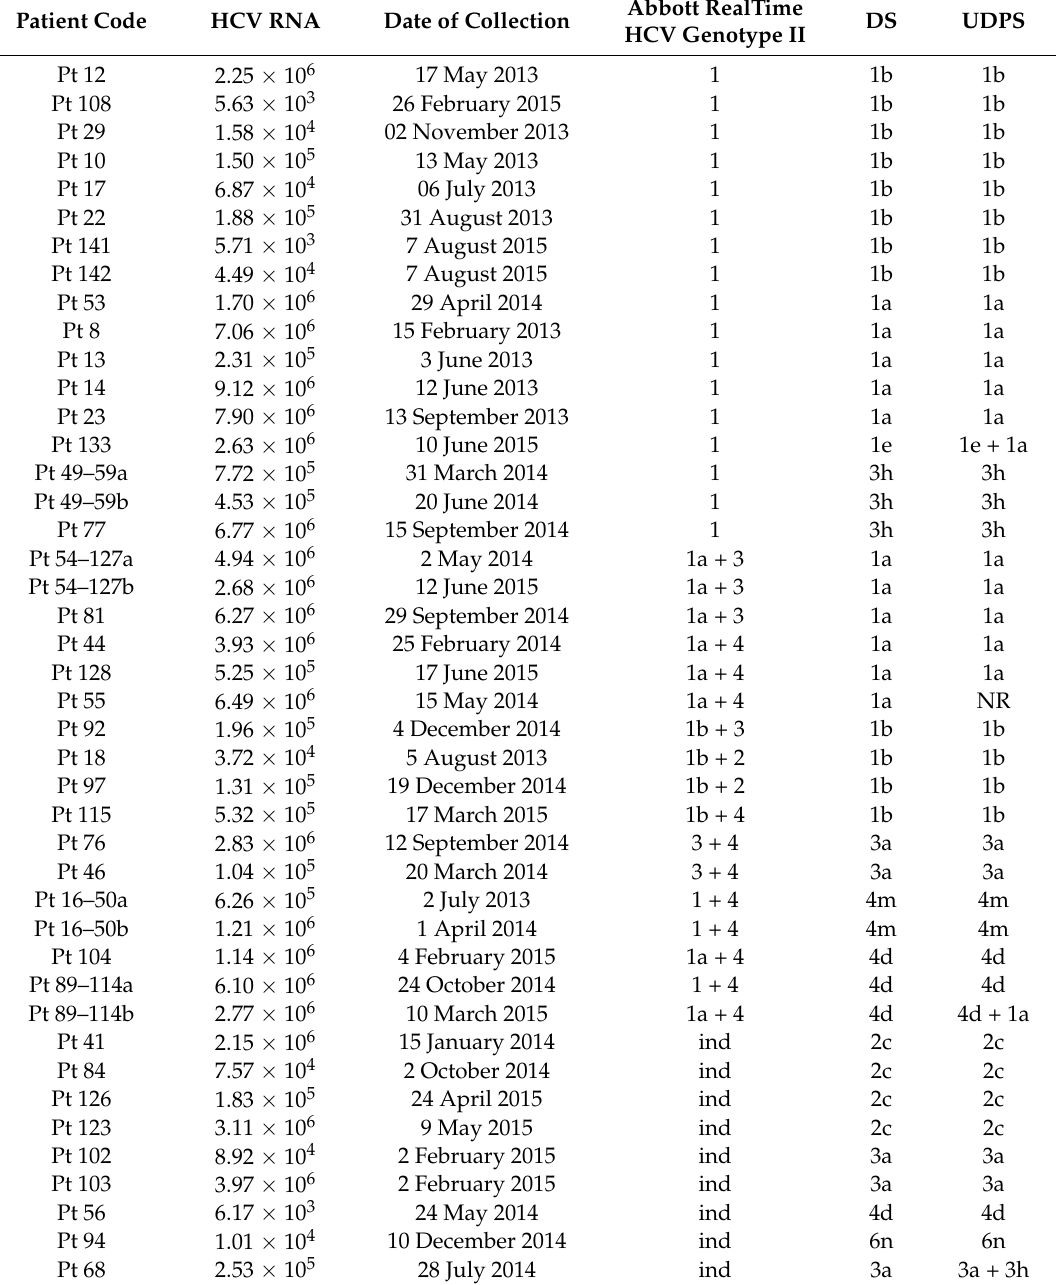
Table 1. Comparison of genotyping results obtained by Abbott RealTime HCV Genotype II commercial assay, direct sequencing (DS) and ultra-deep pyrosequencing (UDPS). Four patients (patient, Pt 49–59, Pt 16–50, Pt 89–114, and Pt 54–127) had two samples collected on different dates, indicated with “a” and “b”. The indeterminate result obtained by the Abbott assay is indicated with “ind”. For Pt 55 no results (NR) have been obtained with